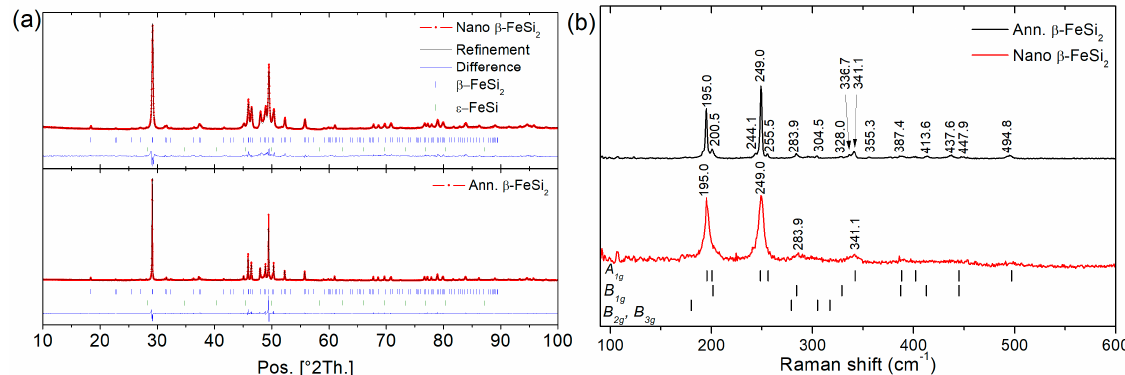
Figure 5. ( a ) Rietveld refinements of annealed β -FeSi 2 (S2 ann. ) and Nano β -FeSi 2 (S2) using FAULTS. ( b ) Raman spectra of annealed S2 ann. and nanostructured S2 β -FeSi 2 sample (with assigned Raman mode [27]).